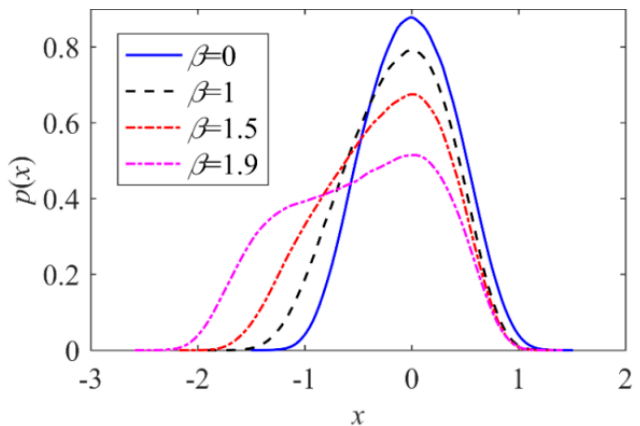
Figure 7. Voltage responses of asymmetric MEHs with different values of quadratic coefficients ( a – d ).